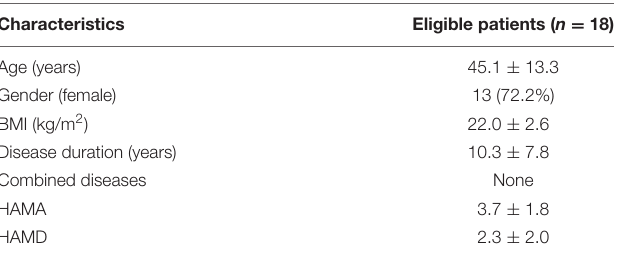
TABLE 1 | Patient characteristics.